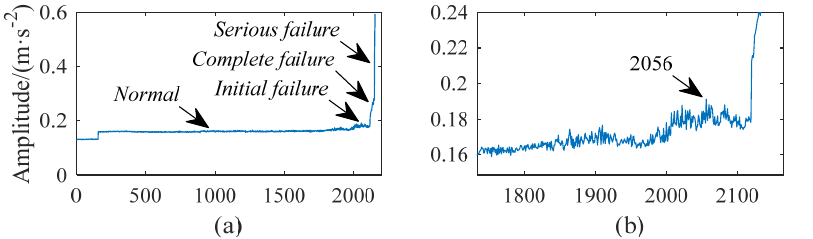
Figure 11. RMS value trend graph and partially enlarged graph of bearing 3 full life data: ( a ) RMS value trend graph; and ( b ) Partially enlarged graph.